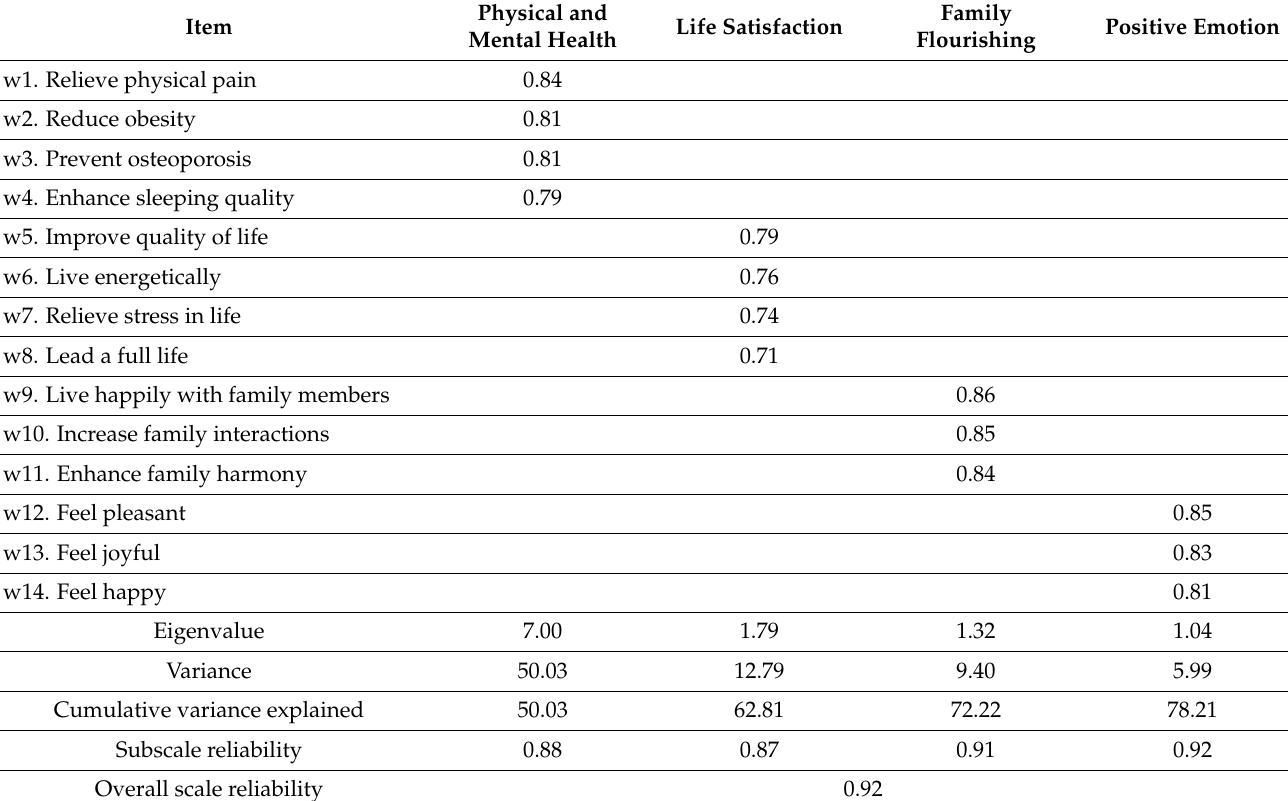
Table 3. Recreational sport well-being scale EFA and reliability